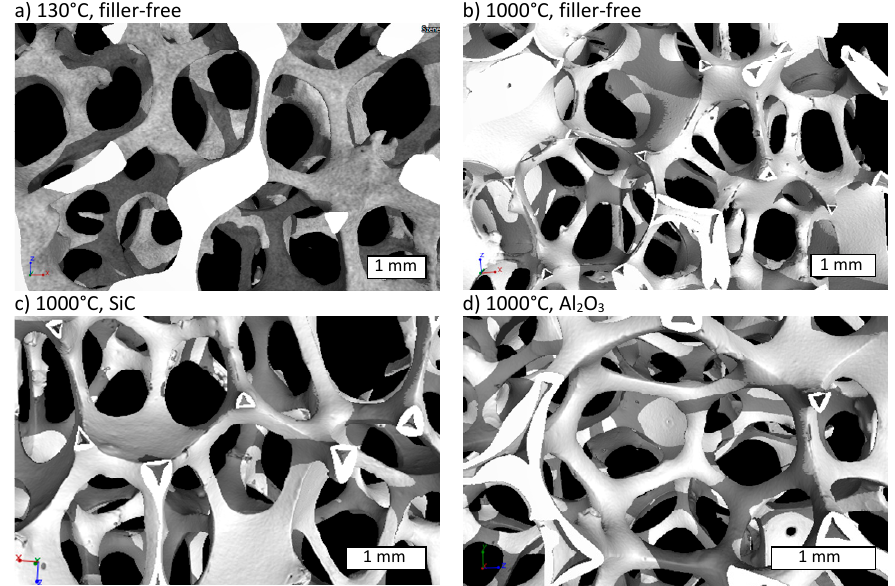
Figure 2. X-ray µ-CT reconstruction image of a volume element representing the typical structure of ( a ) a crosslinked filler-free foam and ( b ) of a filler-free foam pyrolyzed at 1000 ◦ C. Foams pyrolyzed at 1000 ◦ C with fillers are shown in ( c ) with SiC as filler and in ( d ) with Al 2 O 3 as filler. The white bars indicate the length scale of 1 mm.